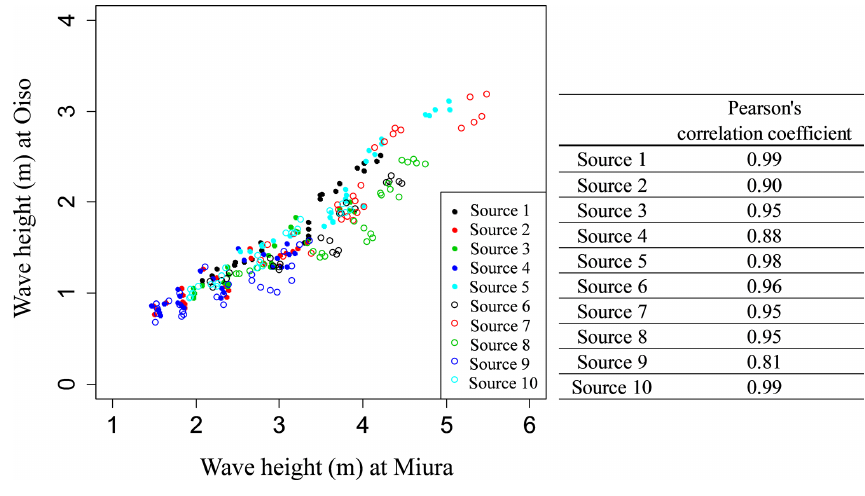
Figure 6. Maximum tsunami wave heights simulated from the tsunami numerical simulation at Miura and Oiso and Pearson’s correlation coefficients in each earthquake